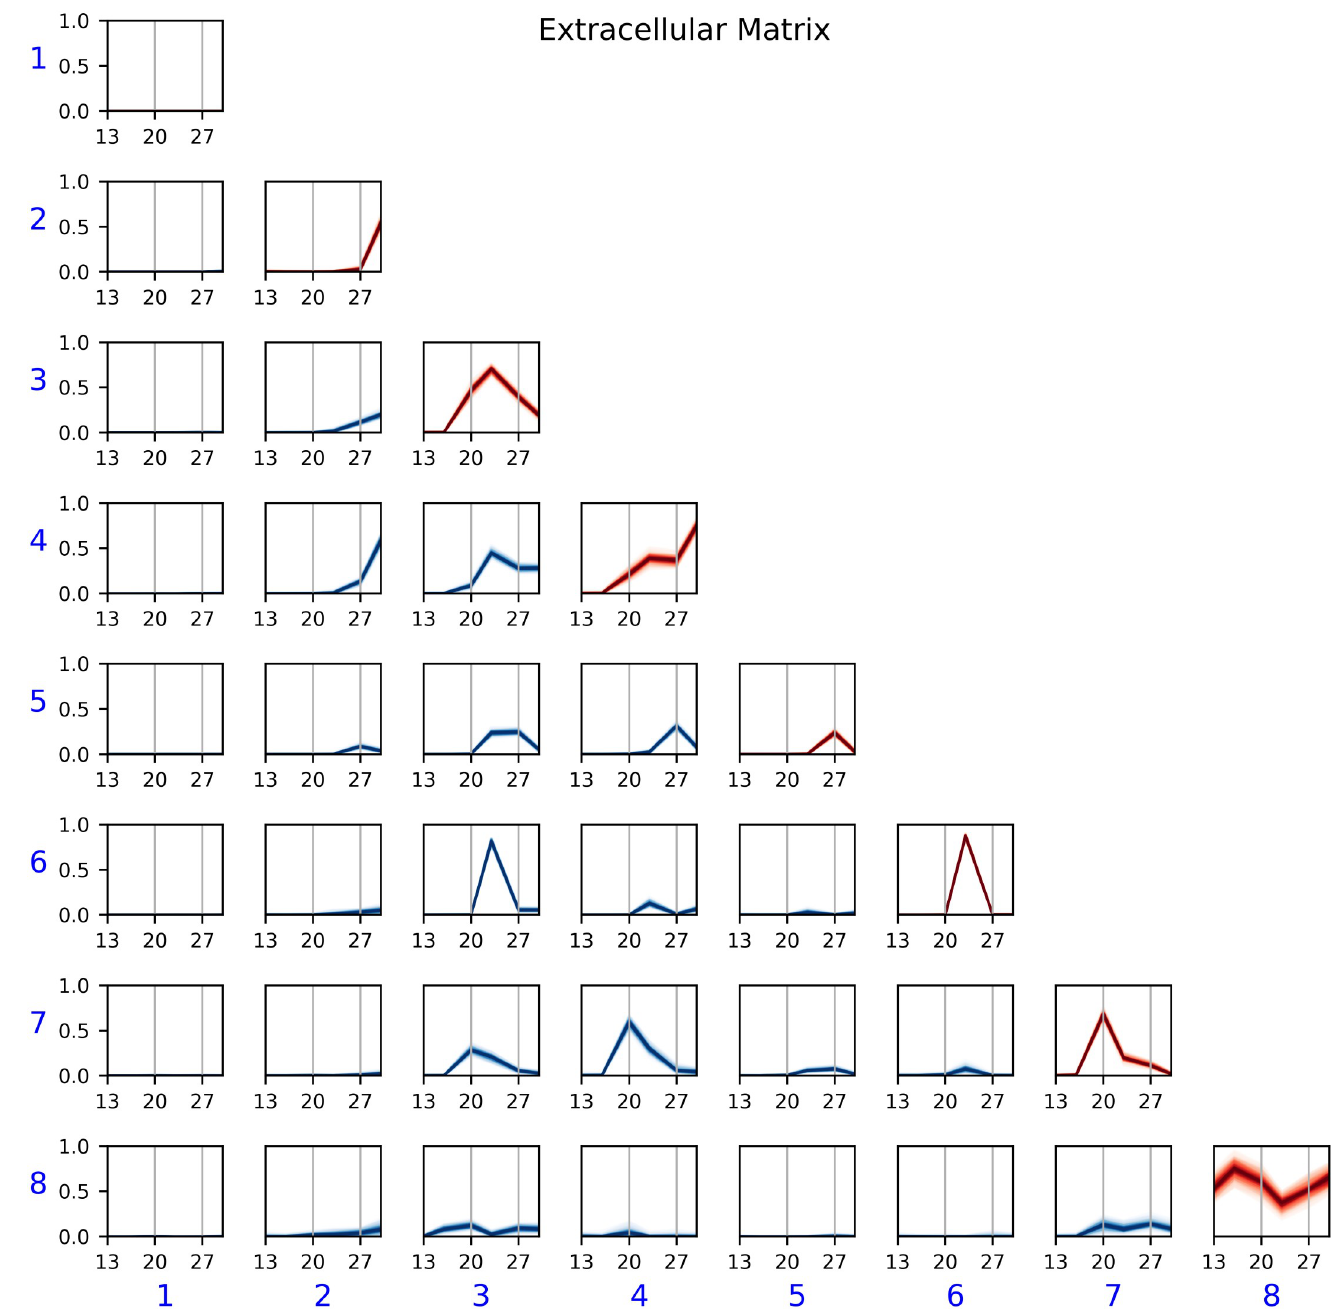
Fig 8. Posterior η ( t ) for the Extracellular Matrix experiment. The model captured various types of temporal behavior. Community 8—mostly associated with bECM cultures—showed high probability of connections throughout the duration of the study. Community 4, in contrast, showed an upward trend with time. The remaining communities captured transient behavior of electrodes that were correlated only in a particular